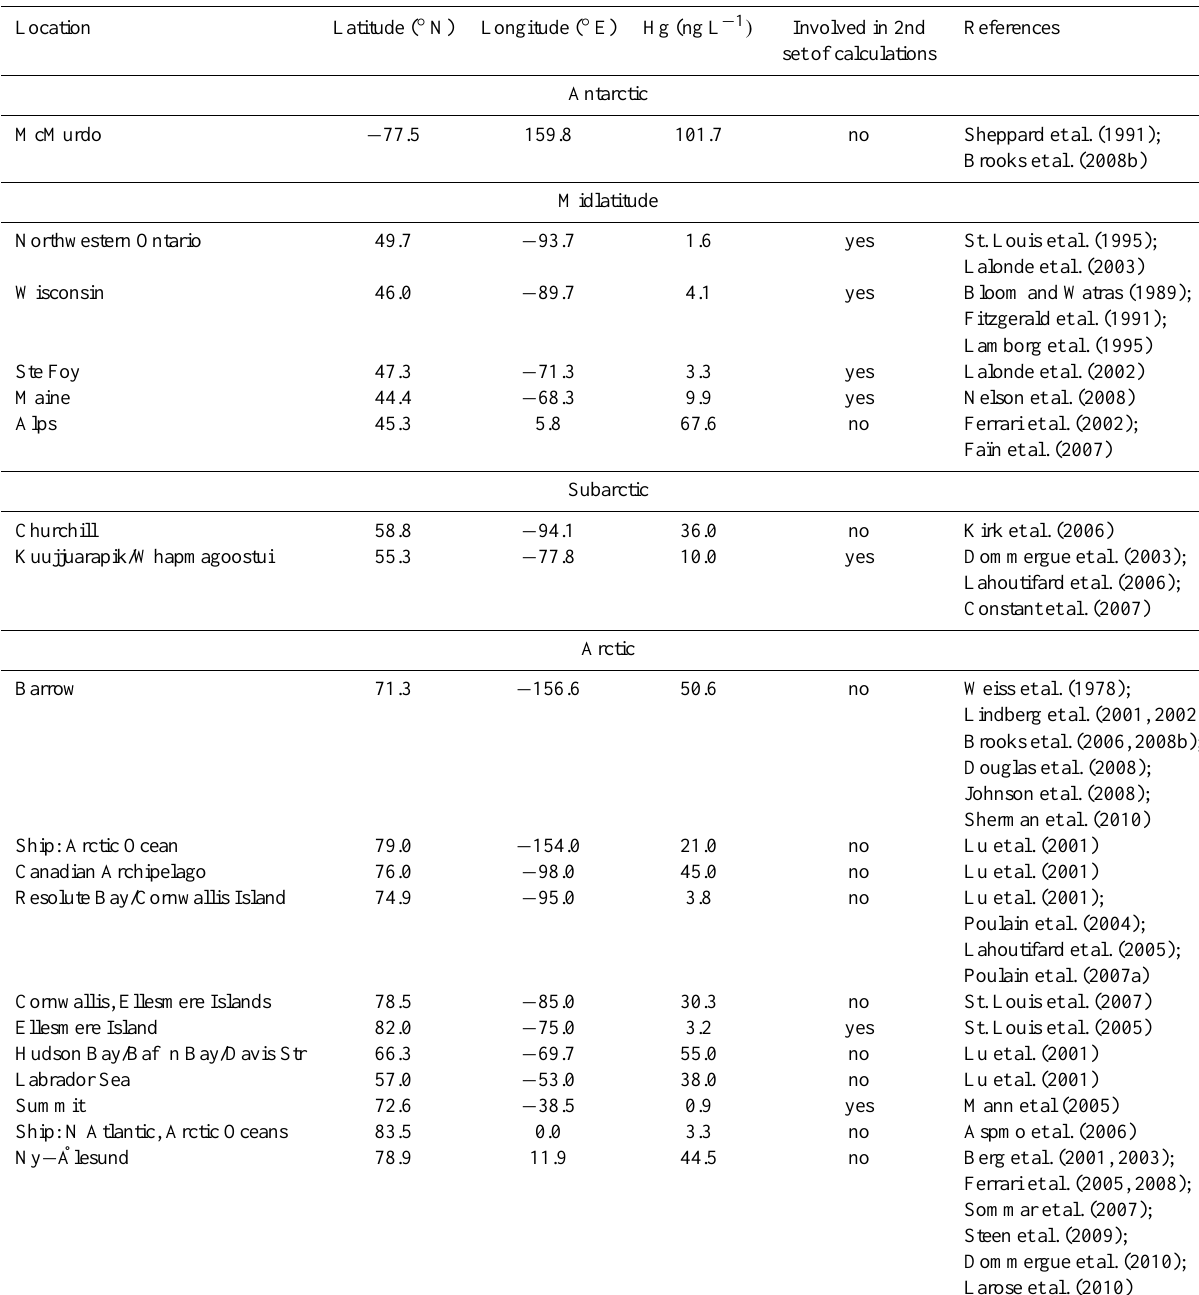
Table 2. Mean concentrations of total mercury in surface